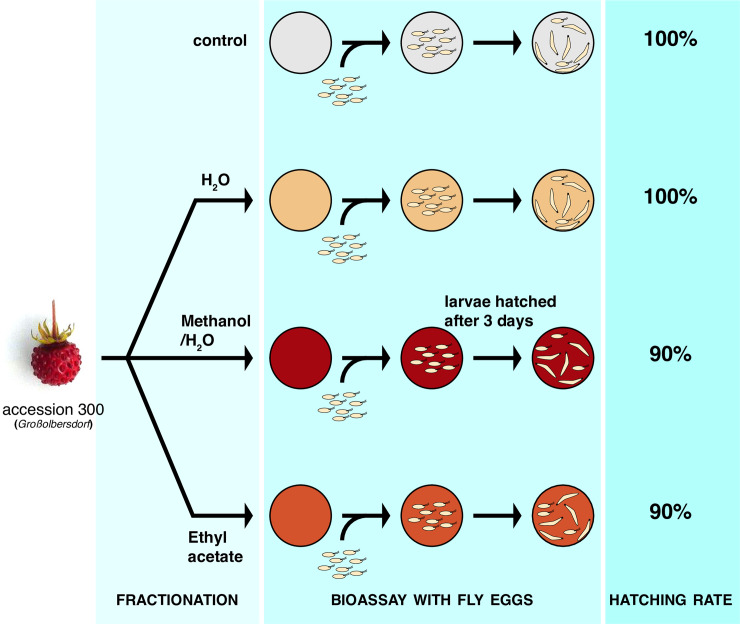
Fractions of Fragaria vesca accession 300 carry antagonist egg activity.The schematic depicts the experimental flow from fractionation to the assessment of fraction activity. Upon fractionation with three different solvents, the fractions were tested in agarose plates onto which fly embryos were let to develop. The hatching rate was reduced for methanol/water and ethyl acetate fractions, but not for the water fraction. All percentages were normalized to the hatching rate of the control.